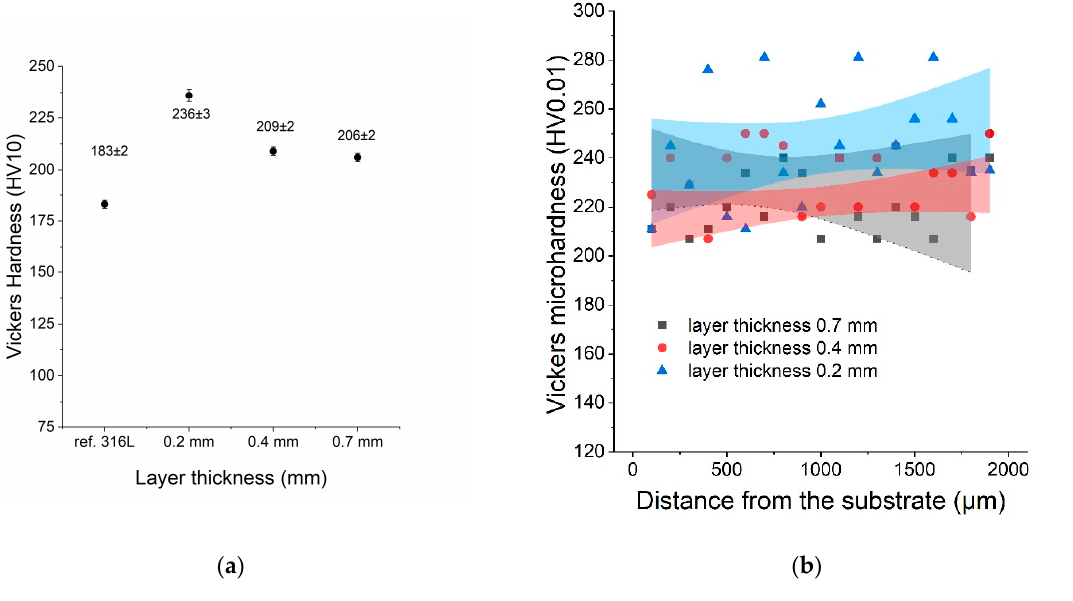
Figure 7. ( a ) Hardness as a function of the layer thickness compared with the reference sample; ( b ) microhardness distribution as a function of distance from the substrate.